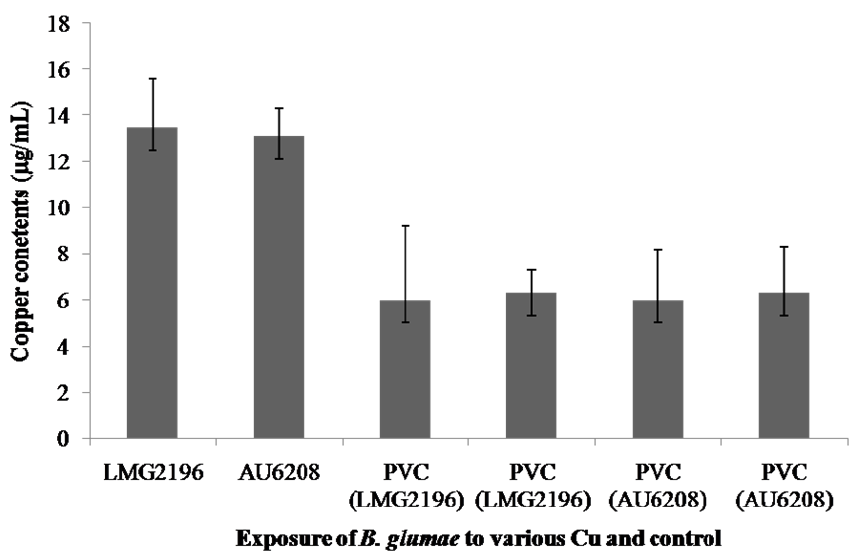
Figure 4. The accumulation of copper in B. glumae cells. The copper contents were measured after 3 h of exposure to metallic copper surfaces, PVC, and stainless steel,